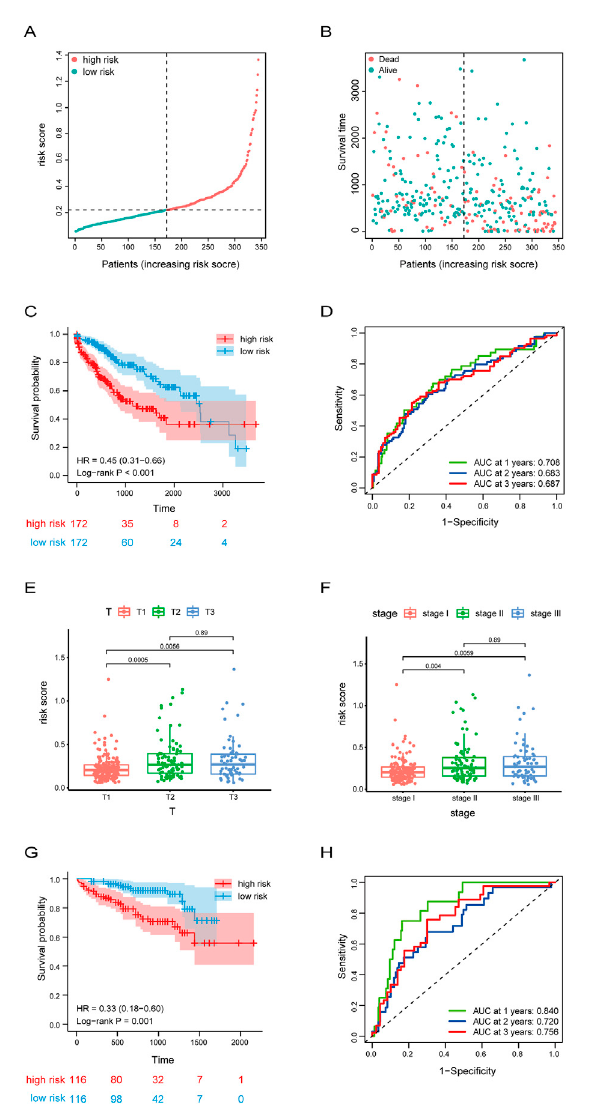
FIGURE 4 Risk score signature predicted prognosis for HCC patients. (A,B) The distribution of risk score, patients ’ survival and status for HCC. The black dotted line divided patients into high risk group and low risk group. (C) Kaplan-Meiersurvivalanalysisofpatientsstrati fi edbythe median risk score in TCGA dataset. (D) The ROC curve was applied to assess the predictive 1-year, 2-year, 3-year performance of riskscore in TCGA dataset. (E,F) Box plot of the difference in risk score for patients withdifferentT-stages (tumorsize)and stages. (G) Kaplan-Meiersurvival analysisofpatientsstrati fi edbythemedianriskscoreinICGCdataset. (H) The ROC curve was applied to assess the predictive 1-year, 2-year, 3- year performance of riskscore in ICGC